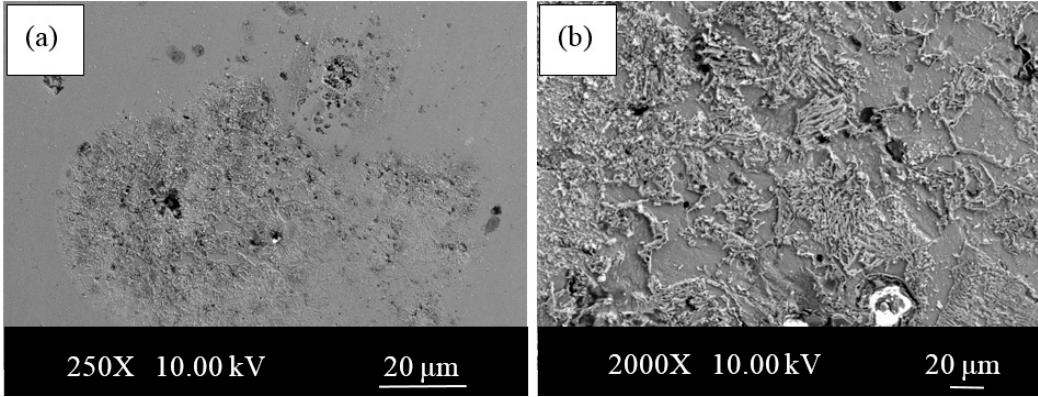
Figure 10. ( a ) SEM image and ( b ) mapping analysis of the alloy 2-NbV-0Ni after corrosion.